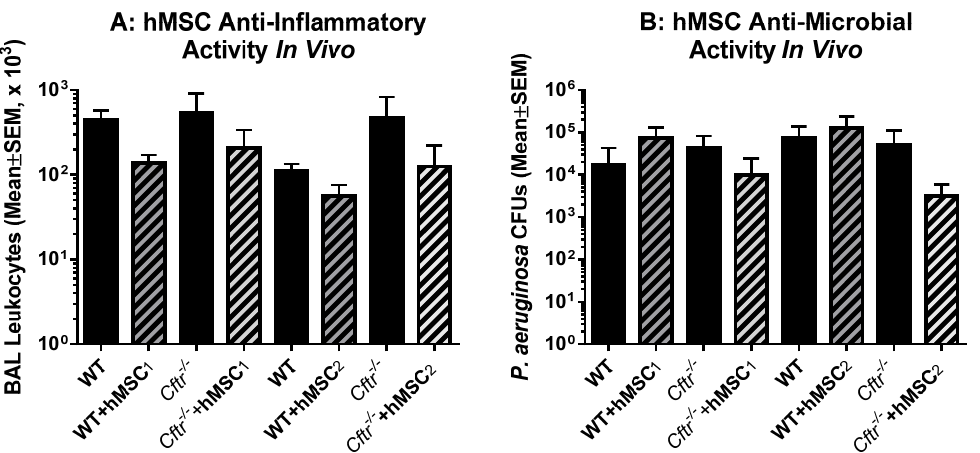
Figure 5. hMSCs in vivo Potency. Two of the pre-GMP hMSCs (hMSC 1 and hMSC 2 ) were selected for their anti-microbial potency and LL-37 production and studied in the murine model of CF P. aeruginosa lung infection using n = 5–6 mice in each group. Both hMSC preparations had anti-inflammatory ( A ) and antimicrobial ( B ) activity in vivo, but neither reached statistical significance. In comparing the “F” variance, hMSC 2 has significant p values for both the anti-microbial and anti- inflammatory outcome measures. ( A ): p ≤ 0.05, total numbers of bronchoalveolar lavage leukocytes; ( B ): p ≤ 0.05, total number of lung P. aeruginosa CFUs. The two different hMSC preparations demonstrated trends towards decreasing both white cell counts and total lung CFUs but did not reach statistical significance. This effect may be due to the variability in the lung infection modeling system or, importantly, the selection criteria hypothesized to be essential in defining the underlying in vivo potency. An evaluation of the groups with and without hMSC treatment for F variance differences demonstrated significance for hMSC 2 with respect to both anti-inflammatory and anti- microbial potency ( p ≤ 0.05). 3. Discussion In previous pre-clinical studies, we evaluated the potential of hMSCs to treat the in- fection and inflammation that is typically associated with CF lung disease [16,20,21]. In these studies, we established the significant variability in effectiveness of hMSCs from different donors. In preparation for the “First in CF” clinical trial, eight different hMSC preparations were screened for potency using in vitro and in vivo models of CF lung infec- tion-induced inflammation. In CF, the conundrum is reducing the host inflammatory re- sponse in the presence of an active bacterial infection. The therapeutics aimed at just the inflammatory piece of the CF pathophysiology have been problematic in providing a ther- apeutic benefit due to concurrent issues with pulmonary infection [1,5,22]. Given the unique pathophysiology of CF, hMSCs were screened for anti-microbial activity against P. aeruginosa , anti-inflammatory activity and production of the antimicrobial LL-37. The hMSC preparation which demonstrated the optimal anti-inflammatory and antimicrobial activities with sustained LL-37 production in response to LPS stimulation was selected for the phase I clinical trial. Of note, the preparation that was ultimately chosen for the clinical trial was from a donor who was CMV negative and met all other FDA screening require- ments. hMSC are a relatively novel and exciting therapeutic option for the treatment of chronic inflammation and infection in CF given their unique capacity to respond and ac- tively contribute to the host environment [23]. The differences between hMSCs and other